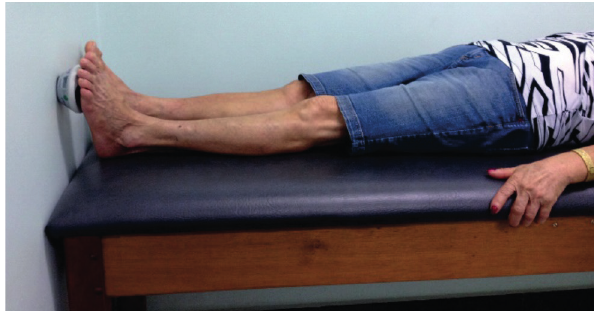
Figure 2 - Evaluation of the force of ankle plantar